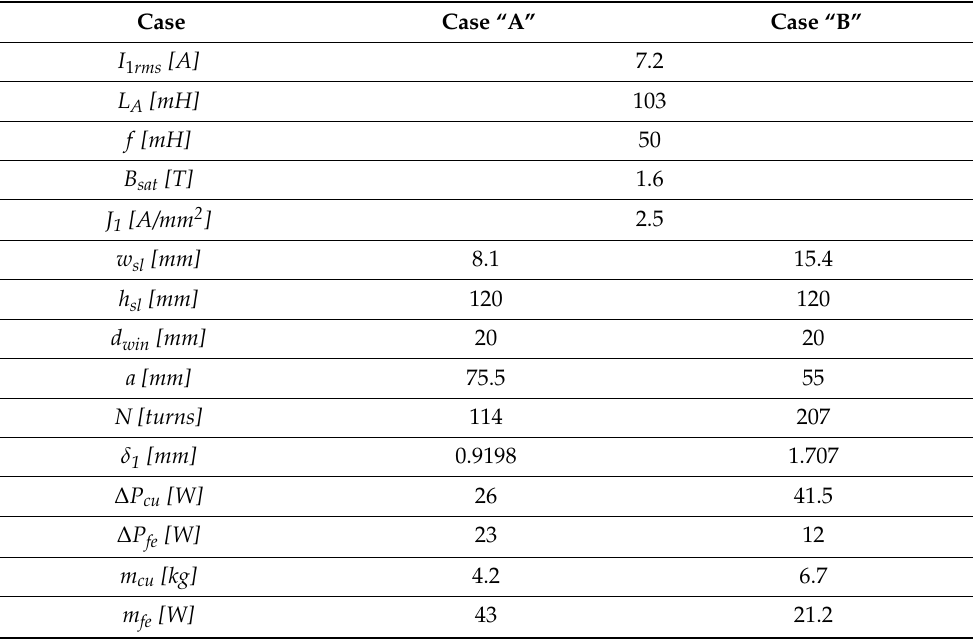
Table 1. The geometric parameters of analyzed chokes derived from proposed analytical design method.